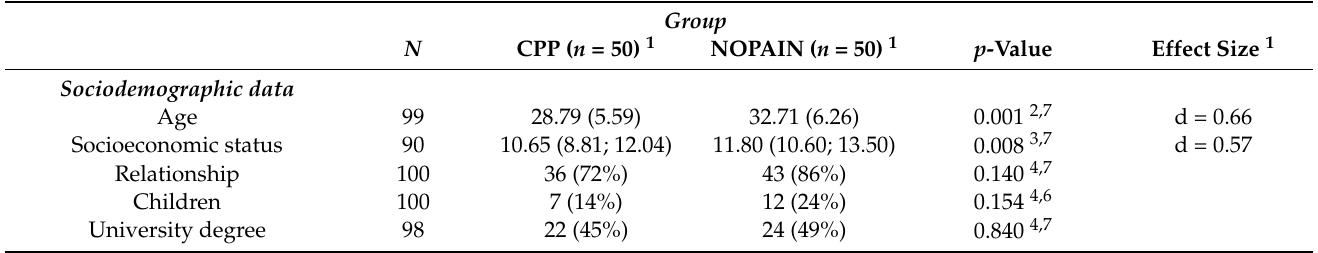
Table 1. Sociodemographic, clinical, endometriosis-related and psychosocial characteristics in the groups CPP and